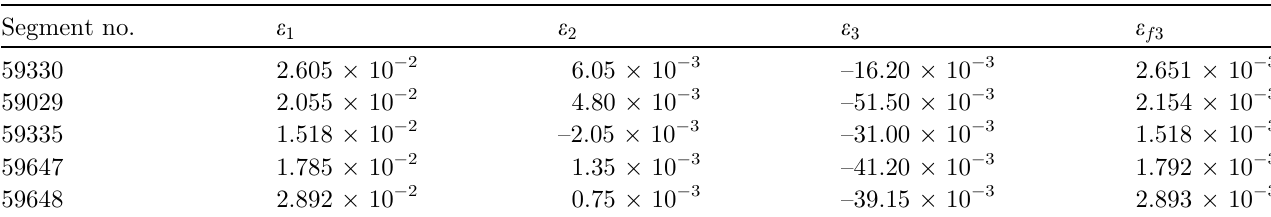
Table 5. Effective strain of the dangerous cross-section segments on the seal ring in natural state. Segment